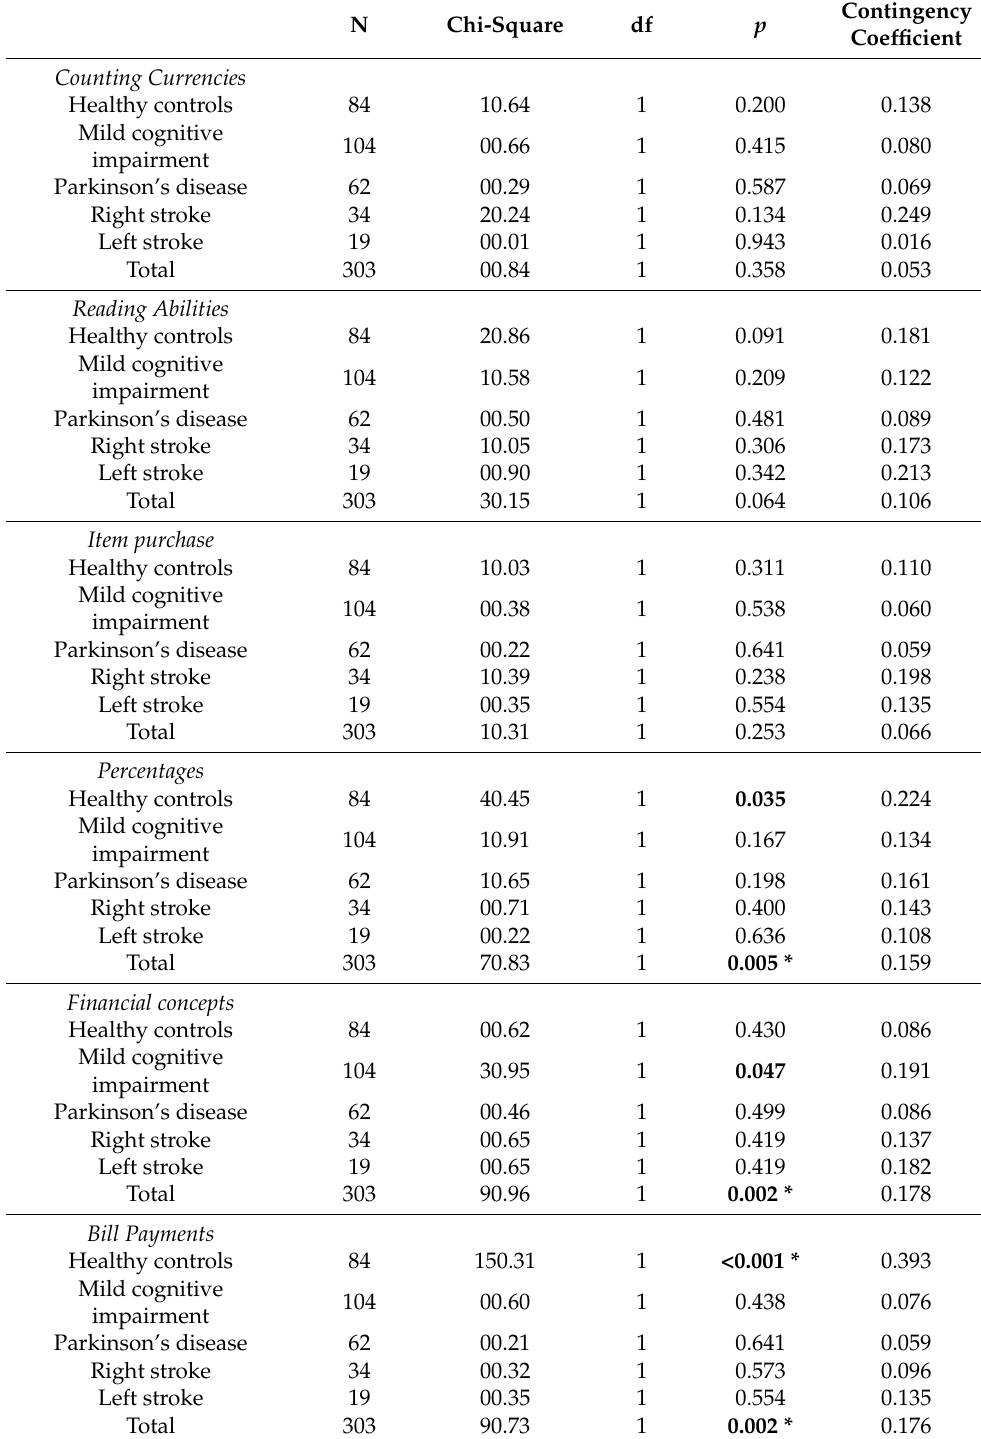
Table 3. Chi-square and p value relative to the association between participants’ deficits in FDM and in each other subtest of the NADL-F short. Significant p -values are reported in